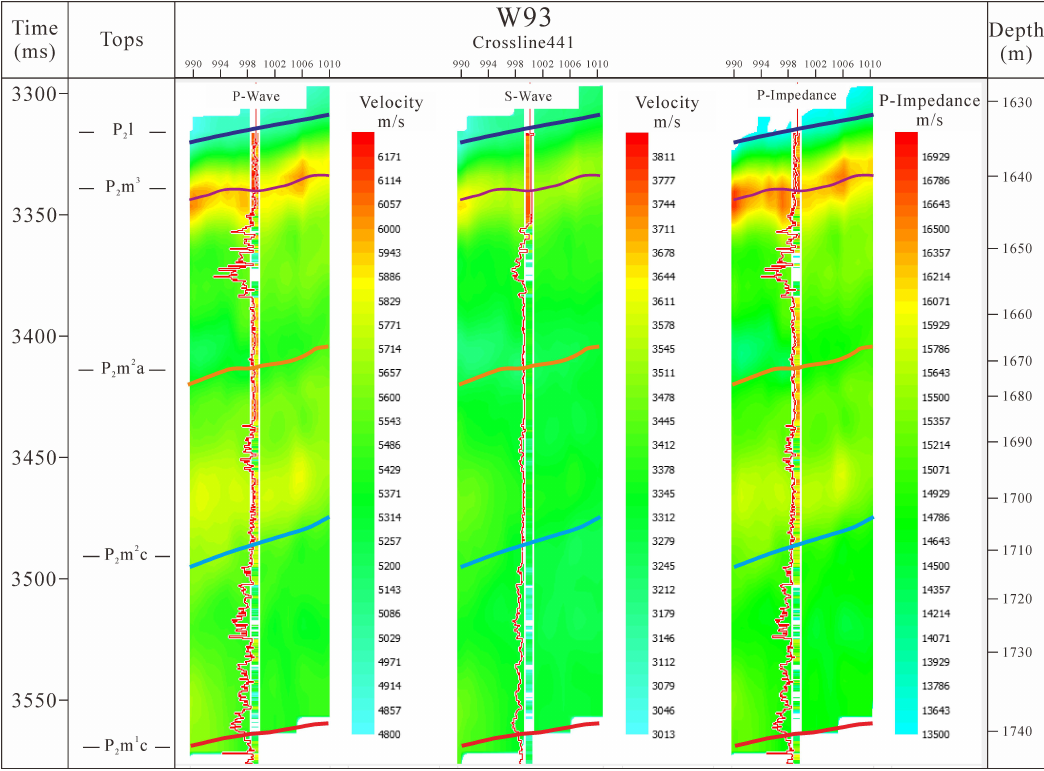
Figure 10. Synthetic seismogram of well W92, which caculated from RHOB and DTC. The results shows a good match between synthetic seismogram with the observed seismic reflection.